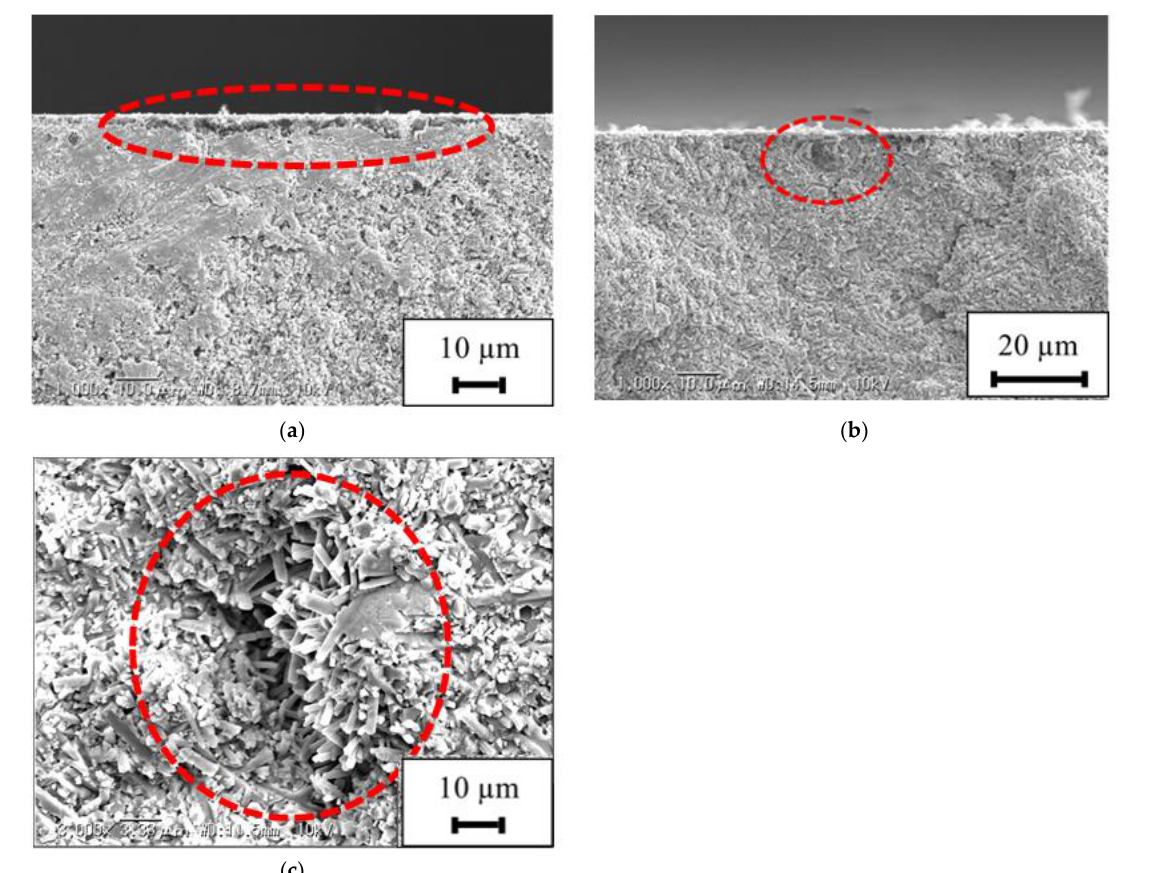
Figure 11. Fracture surface and fracture origin: ( a ) Non-LP specimen ( σ B = 1123 MPa; surface fracture origin); ( b ) LPC-1 specimen ( σ B = 1192 MPa; surface fracture origin); ( c ) LPwC-1 specimen ( σ B = 1201 MPa; inner fracture origin at depth of 38 µm).